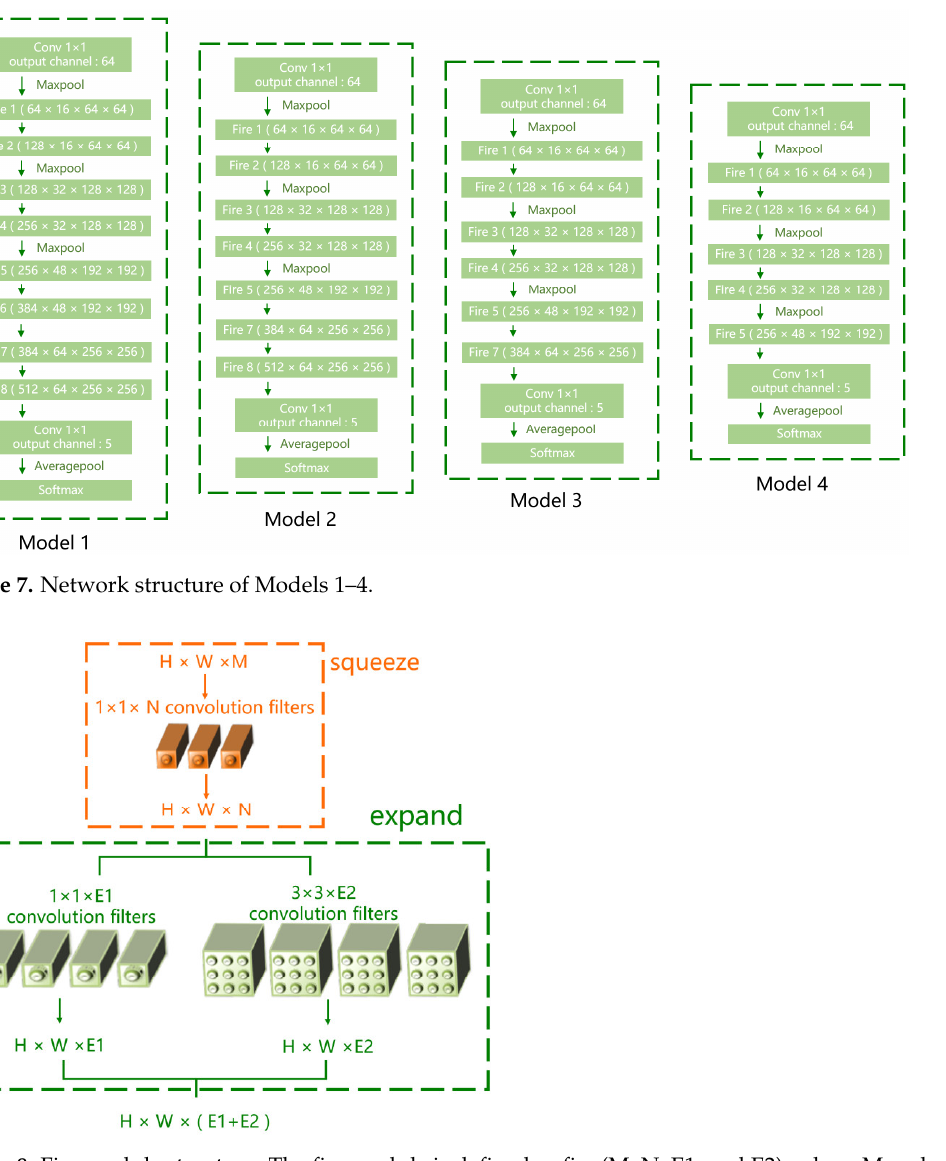
Figure 8. Fire module structure. The fire module is defined as fire (M, N, E1, and E2), where M and N represent the number of input and output channels, respectively, of the squeeze layer. E1 and E2 represent the number of output channels of expand layer 1 × 1 and expand layer 3 × 3, respectively.